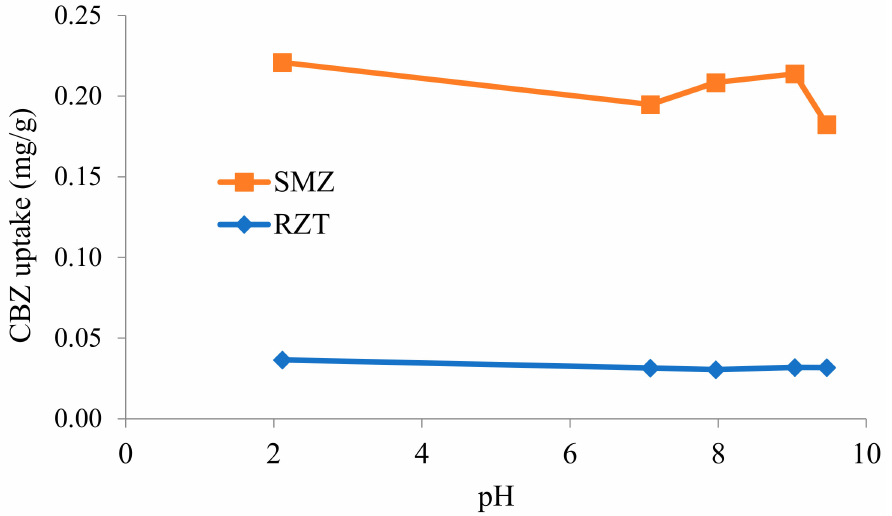
Figure 4. The effect of pH on the carbamazepine (CBZ) adsorption capacity for RZT and